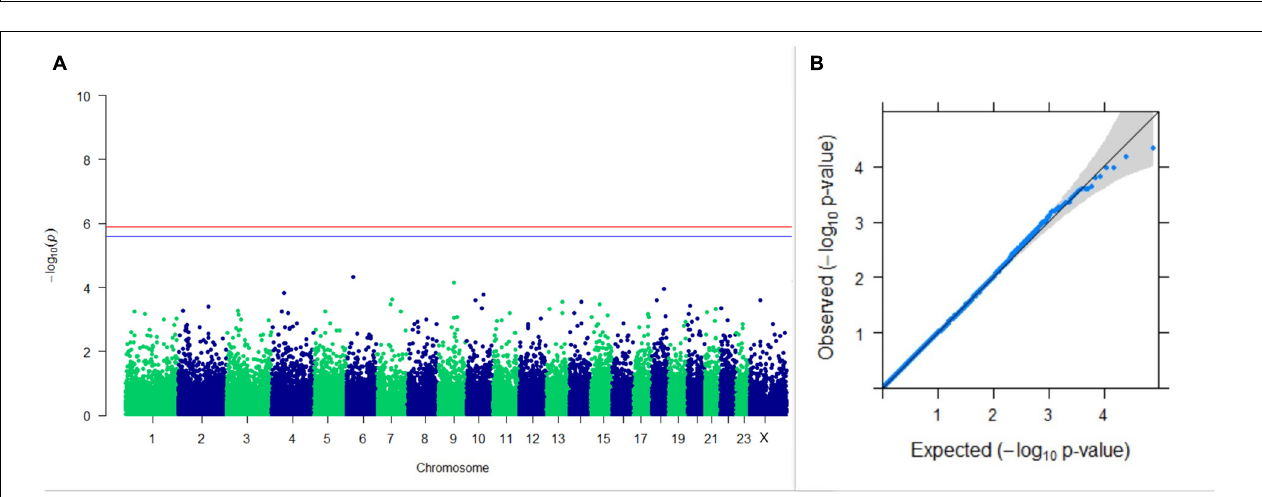
FIGURE 9 | Results of GWAS for lactation persistency according to Johansson and Hansson. (A) Manhattan plot of genome-wide SNPs. The red line indicates the p- value threshold (expressed as –log 10 P ) corresponding to FDR-corrected p- values or q = 0.05, above which the SNPs are considered to be significantly associated with the trait, while the blue line indicates genome-wide the suggestive threshold at q = 0.1. The SNPs identified on chromosome no. 24 were screened out from analysis because of stringent quality control; hence, it is not represented in the Manhattan plot. (B) Q-Q plot of the p- values.